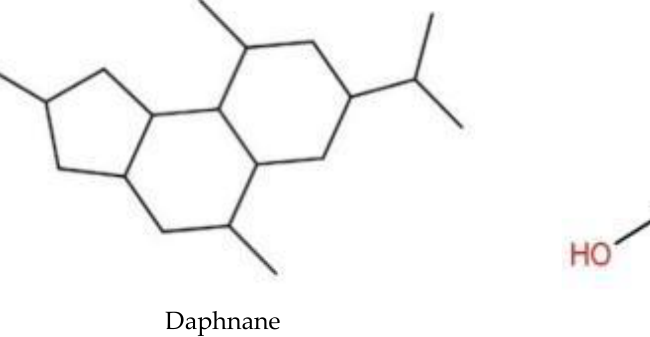
Figure 5. Structure of some adaptogen molecules.